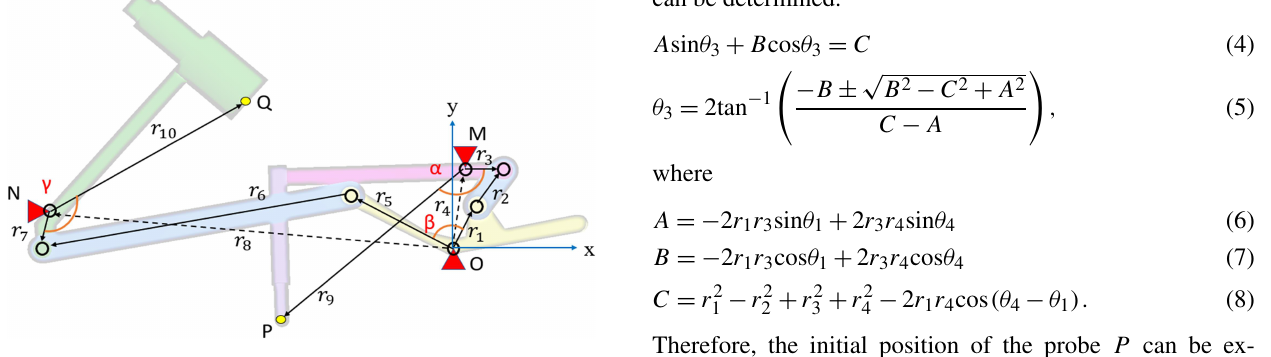
Figure 6. Vector loops of the screw-positioning mechanism.